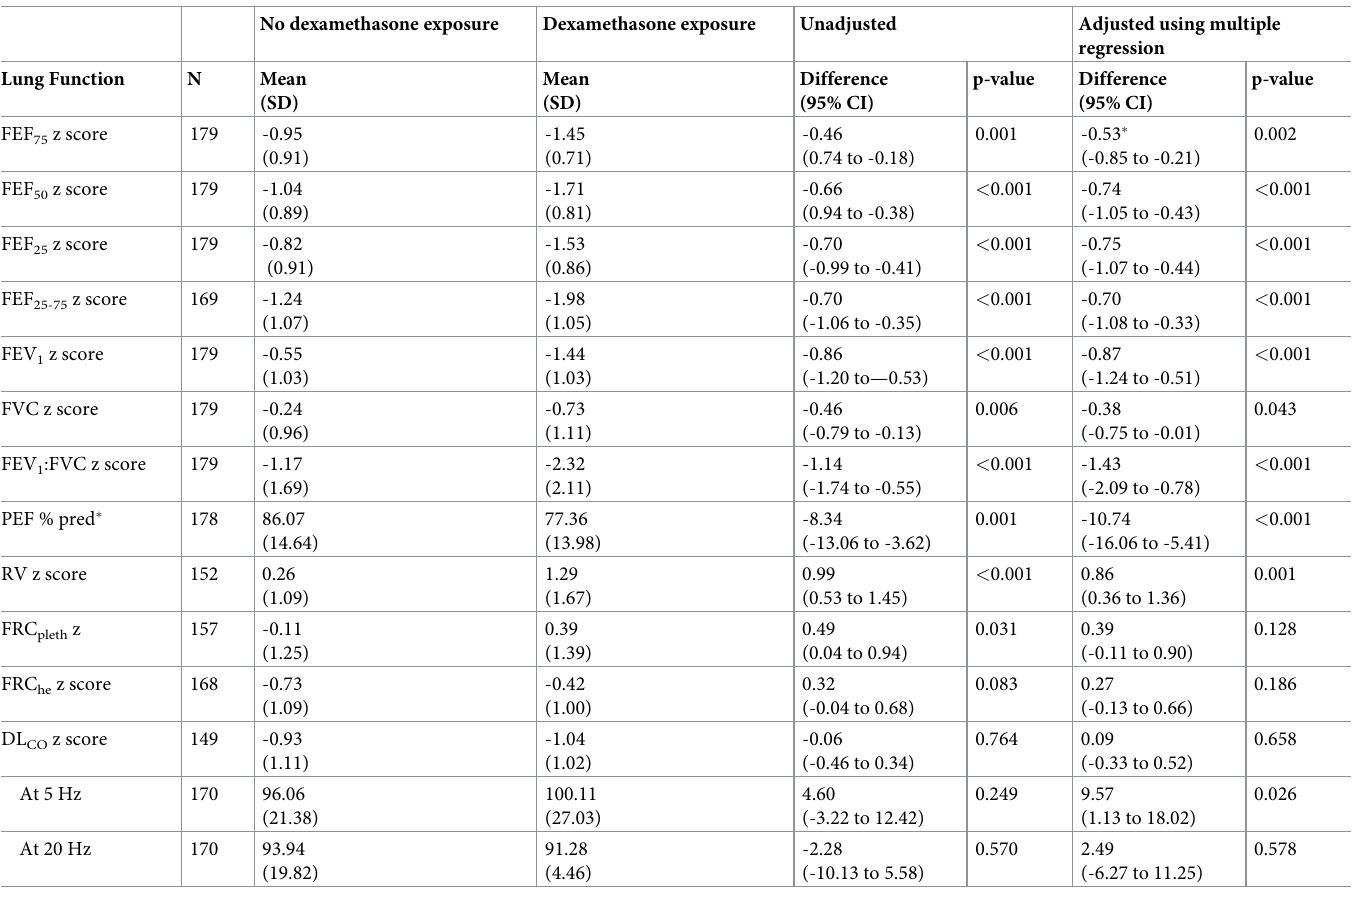
Table 2. Lung function and postnatal dexamethasone